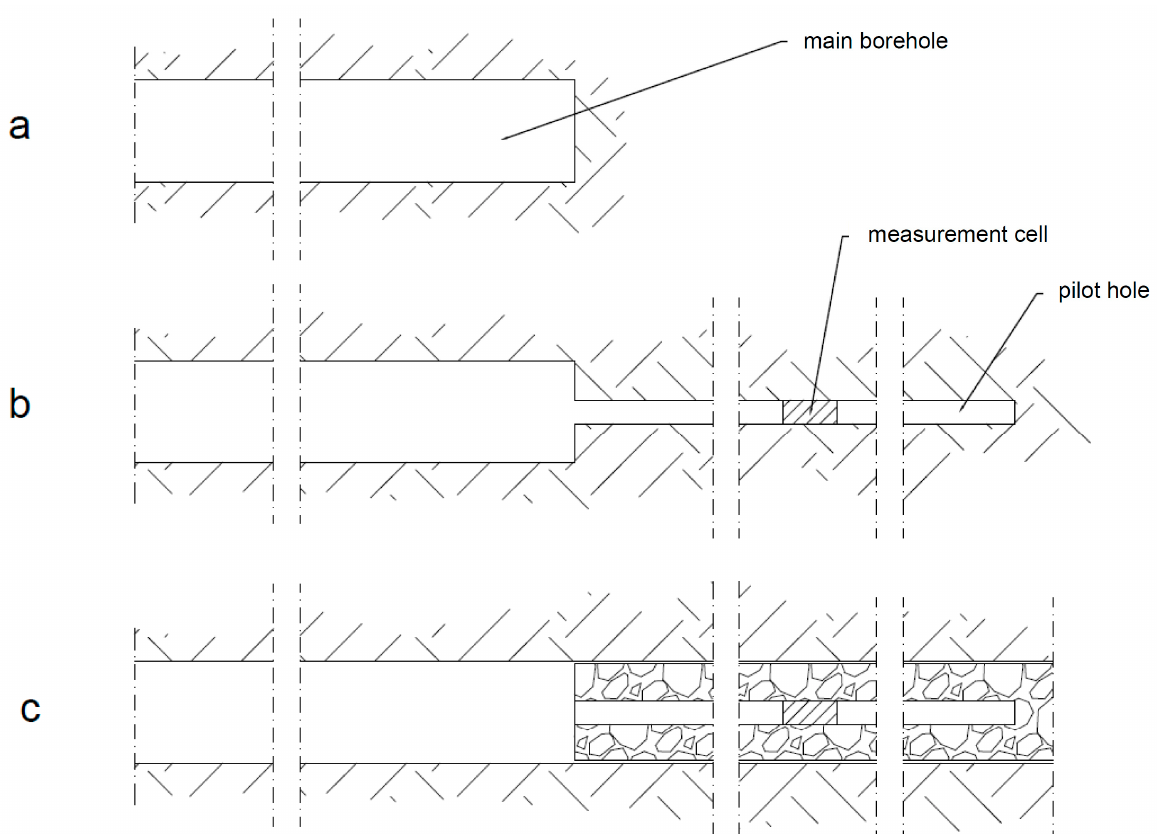
Figure 3. Stages of the overcoring method. ( a ) boring a hole in the rock which has a large-diameter (60–220 mm) and a length sufficient to treat the influence of the mining excavation as negligible; ( b ) driving a pilot hole typically 38 mm in diameter and placing a measurement device (probe) in the pilot hole; ( c ) effecting stress relief in the cut-out cylinder, whose deformations are recorded with a measurement device.